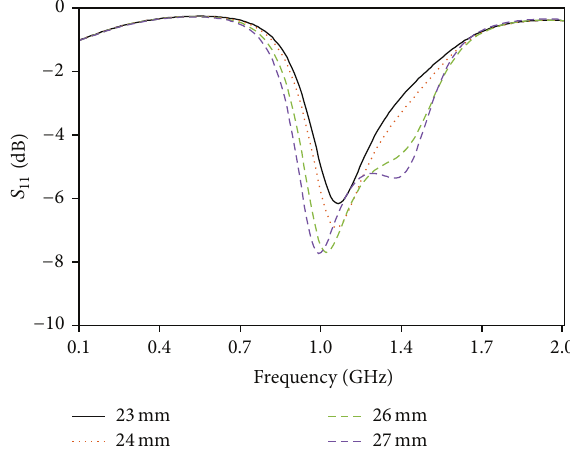
Figure 3: S 11 response for the change in major radius (ratio = 1.4) of the inner elliptical shape of the annular ring at patch.